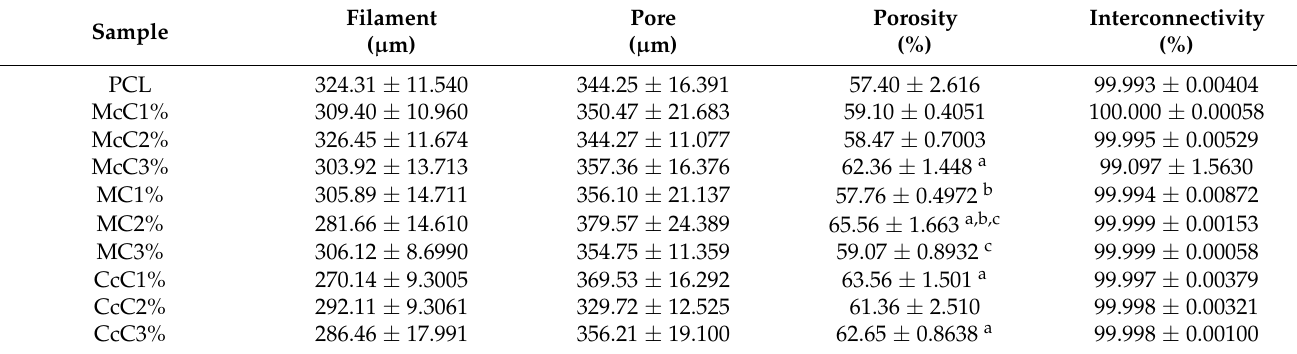
Table 4. Filament and pore dimensions, porosity, and interconnectivity of the scaffolds (mean ± SD) assessed through micro-computed tomography